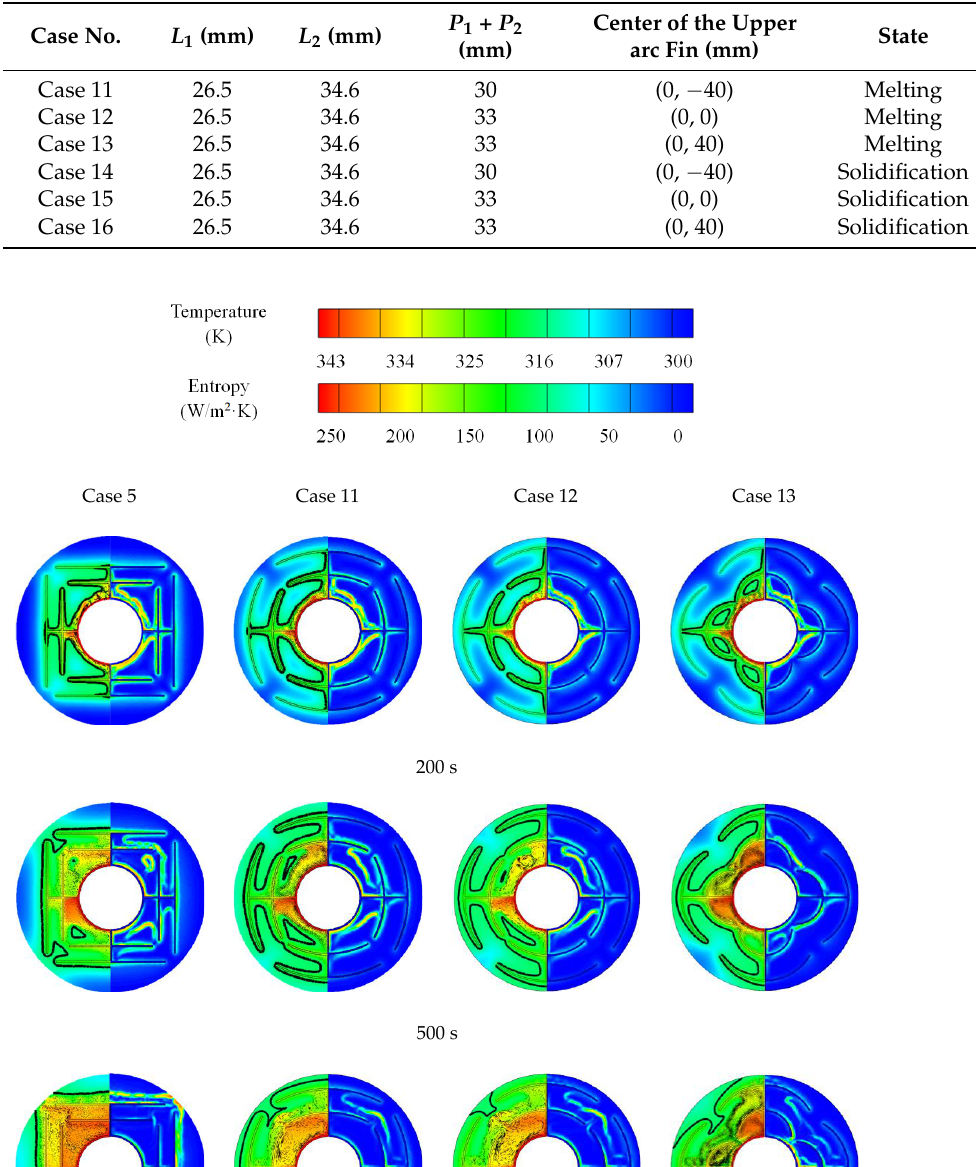
Table 3. Arc-shaped fin parameters and discussed cases.